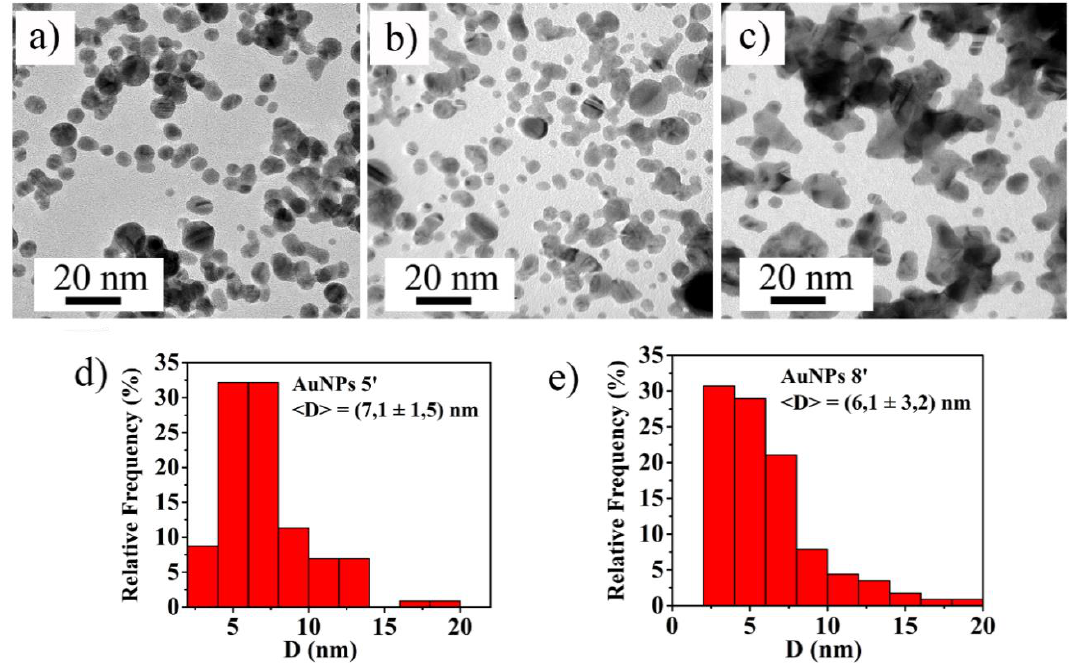
Figure 2. TEM images of synthesized 5′ Au nanoparticles (AuNPs) ( a ), 8′ AuNPs ( b ) and 12′ AuNPs ( c ). Diameters distribution of 5′AuNPs ( d ) and 8′ AuNPs ( e ).